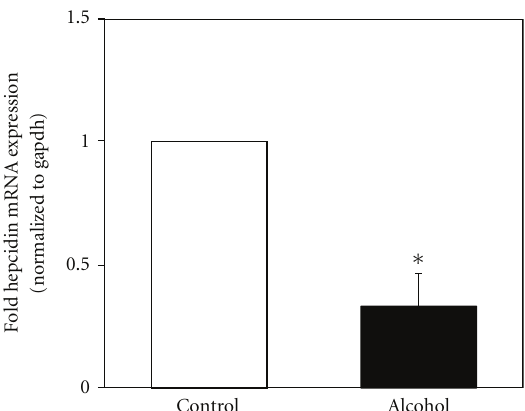
Figure 5: Alcohol and Hepcidin Expression . cDNA was synthesized from liver RNA of mice fed with regular (control) or ethanol-containing (alcohol) Lieber-De Carli liquid diets, as described in Materials and Methods. It was employed in real-time PCR to detect hepcidin expression. The mRNA expression in alcohol-fed mice was expressed as-fold of that in pair-fed control mice fed with regular diet (mean ± S.E.M.; n = 3, 4 mice per group). Asterisks indicate statistical significance ( P < 0 .